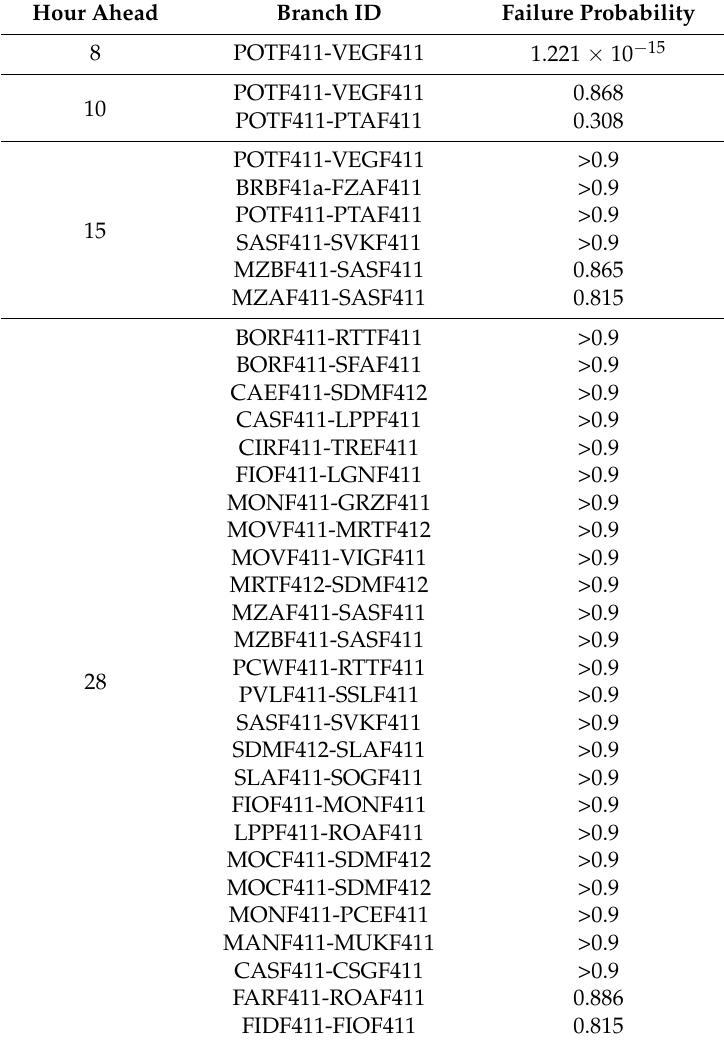
Table 3. List of critical branches with their failure probabilities for hours 8, 10 15 and 28 in the forecast